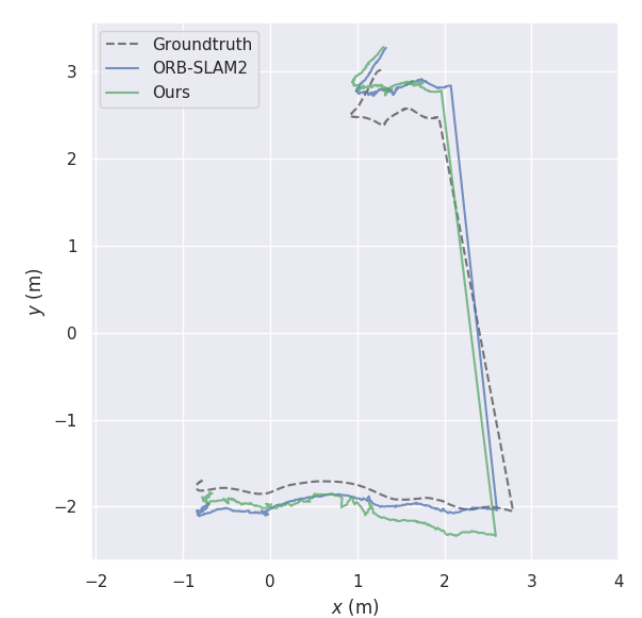
Figure 8. The comparison of the trajectories for ground truth, ORB-SLAM2, and our method on dataset RGBD_f2_no_loop.